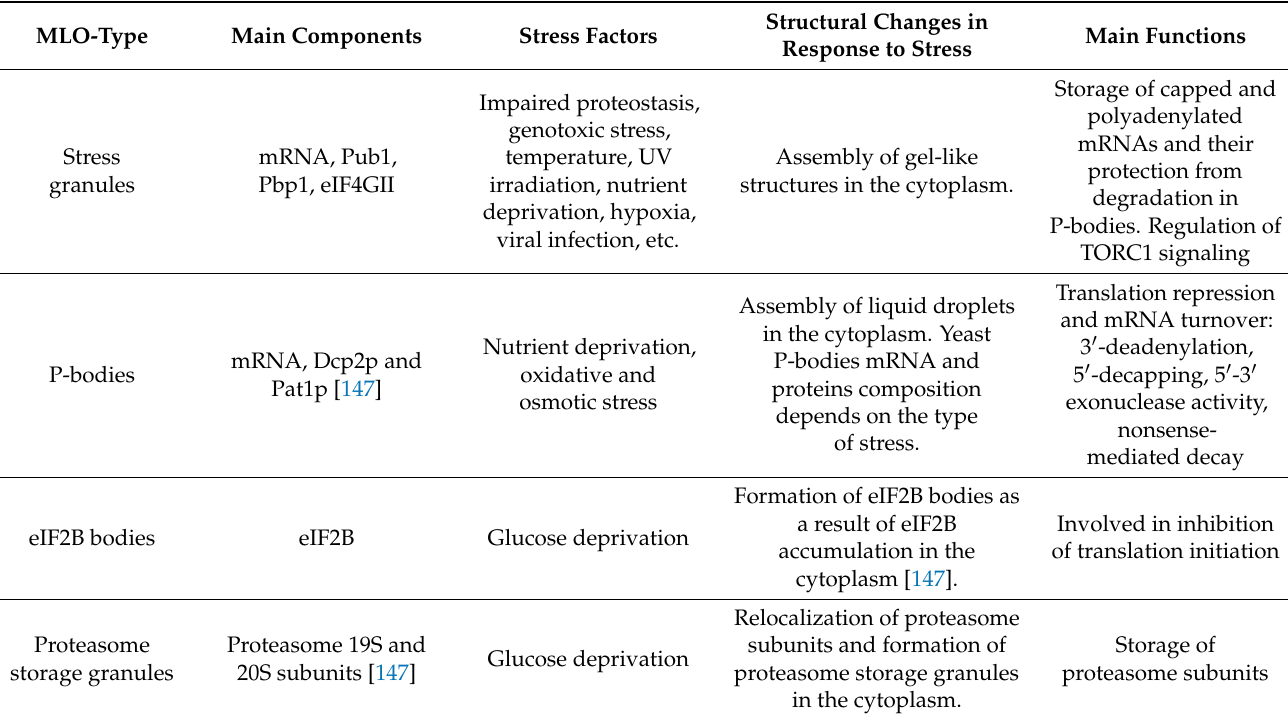
Table 2. Examples of LLPS (or suggested to be LLPS) compartments formed or rearranged in response to in yeast